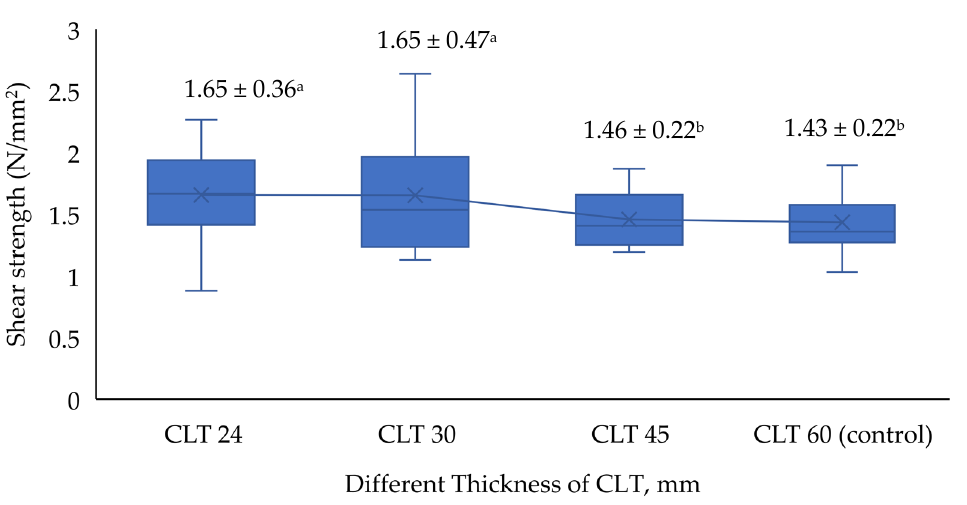
Figure 11. Mean and standard deviation of shear strength with different letters (a, b, c, and d) for different targeted thicknesses of CLT (CLT 24, CLT 30, CLT 45, and CLT 60) indicate significant differences at p ≤ 0.05.